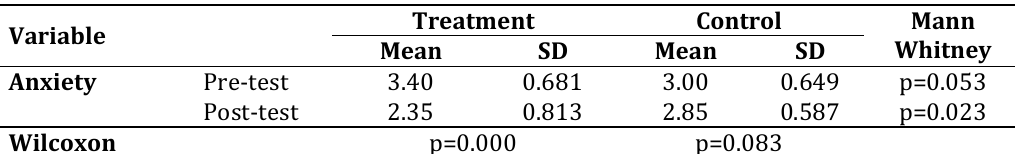
Results of Mann Whitney and Wilcoxon Signed Ranks Test in children before and after intervention in Srikandi Room Jombang Hospital in 2021